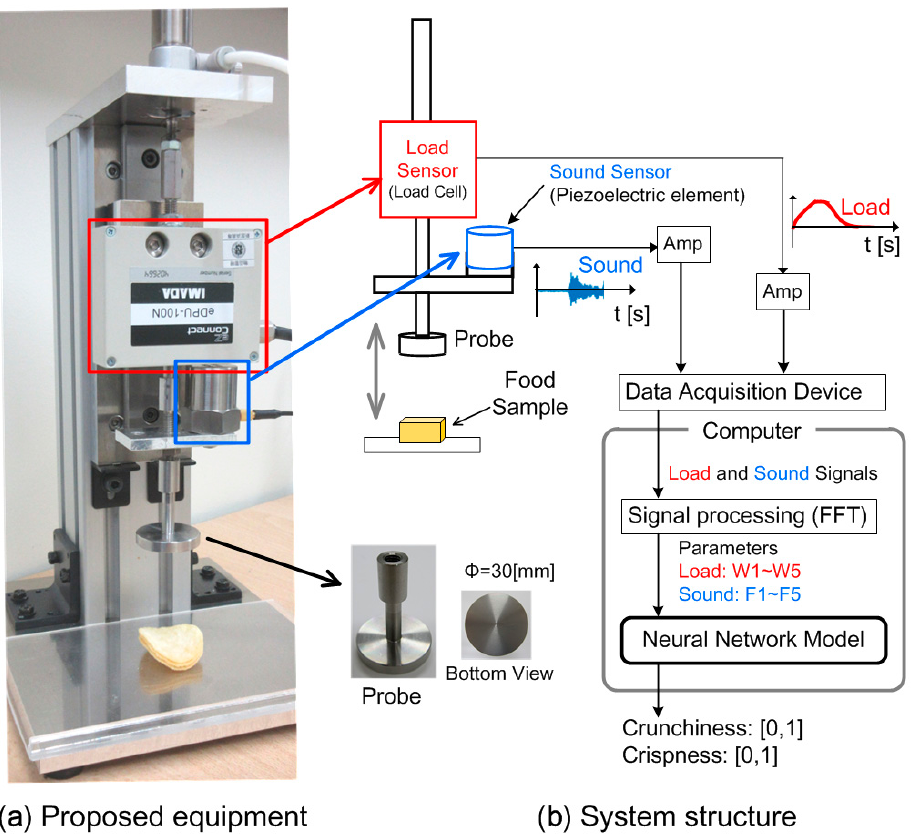
Figure 2. System construction: ( a ) Image of the proposed equipment and; ( b ) system structure for estimation of “crunchiness” and “crispness” textures.